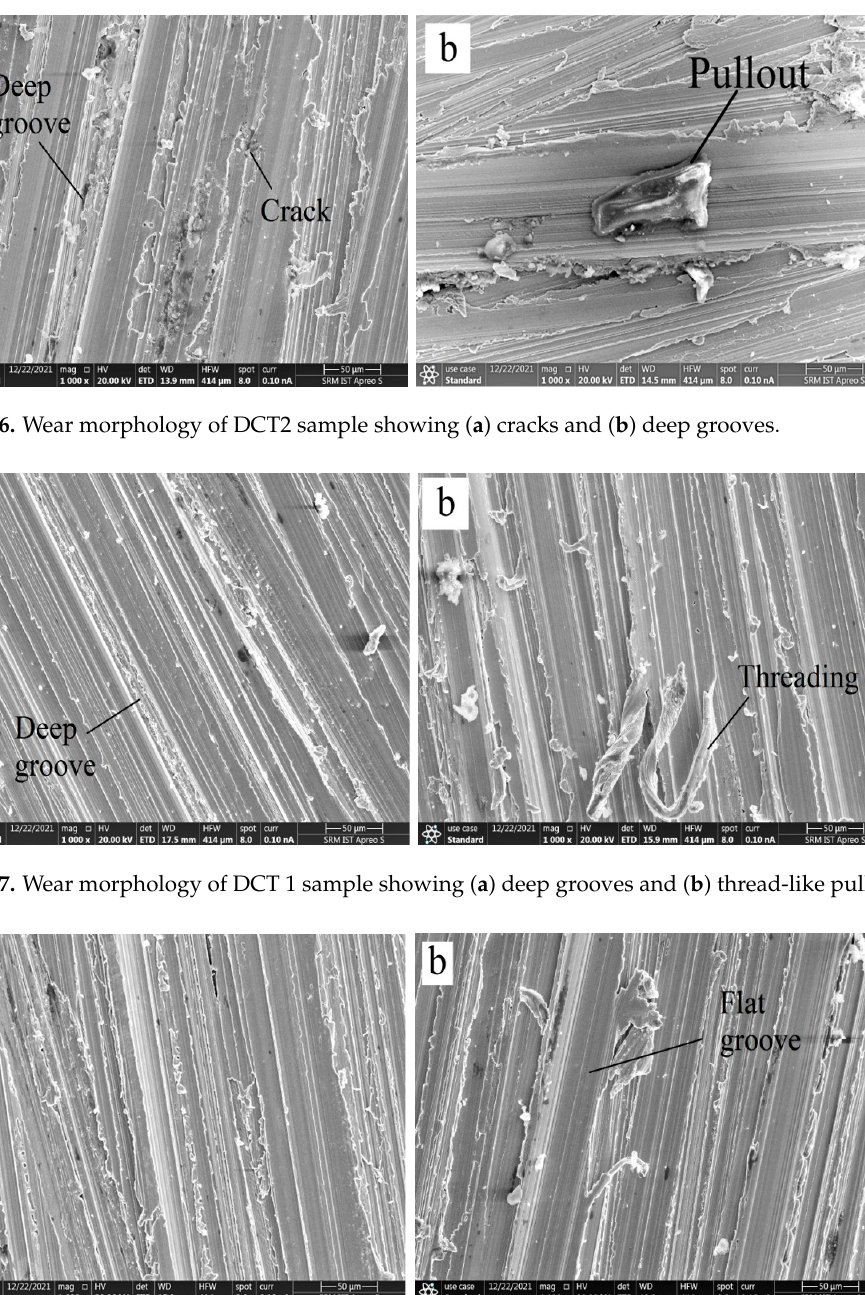
Figure 8. Wear morphology of DCT 3 sample showing ( a ) limited grooves and ( b ) flat grooves with reduced wear loss.